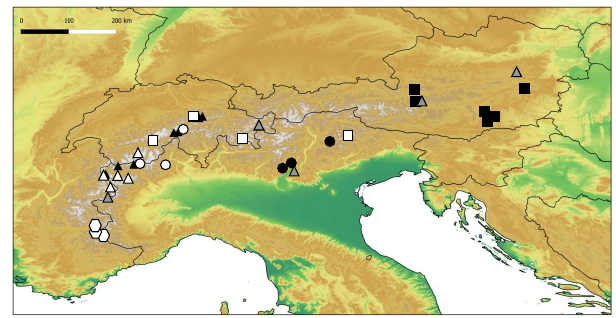
Figure 1. Map of the Alps with locations of sampled Crenobia alpina populations. Different symbols refer to the grouping revealed by the phylogenetic analyses (see Fig. 2). Groups with distinct geo- graphic structuring: southwestern Alps – white diamonds; western Alps – white triangles; northwestern Alps – black triangles; south- ern Alps – black circles; eastern Alps – black squares. Groups with- out distinct geographic structuring: mixed clade I – white circles; mixed clade II – white squares. Haplotypes indicated by grey trian- gles could not be assigned to a geographic